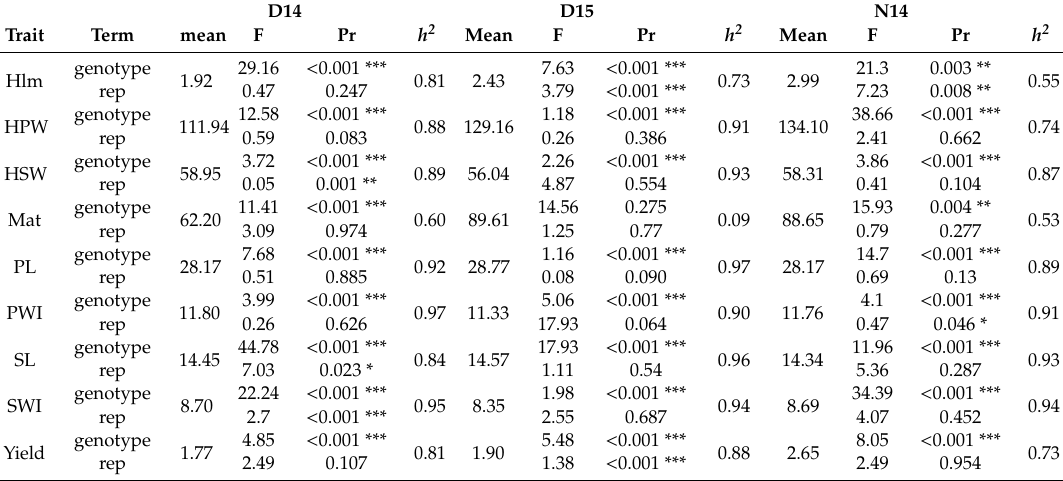
Table 2. Variance components for fixed e ff ects of single-site mixed-model